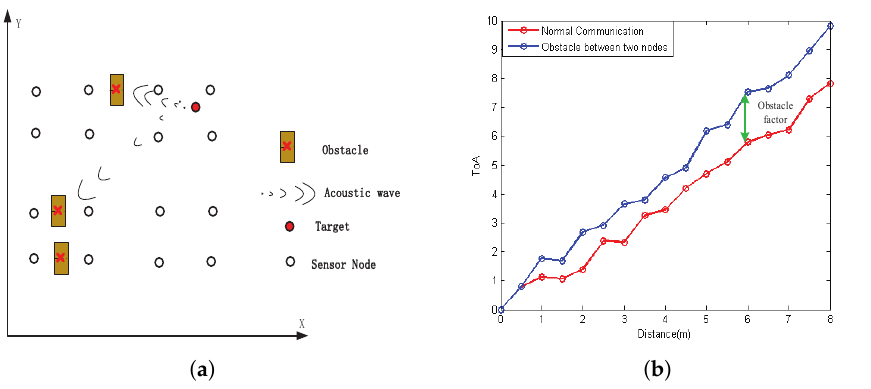
Figure 2. ( a ) The target is occluded by obstacle; ( b ) ToA measurement in the situation of obstacle between two